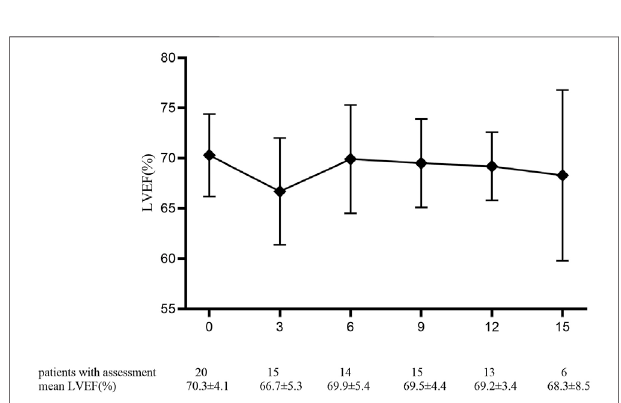
FIGURE 2 | Pre-trastuzumab baseline and value of left ventricular ejection fraction percentage in 20 patients at each monitoring timepoint. Data are presented as mean ± standard deviation.